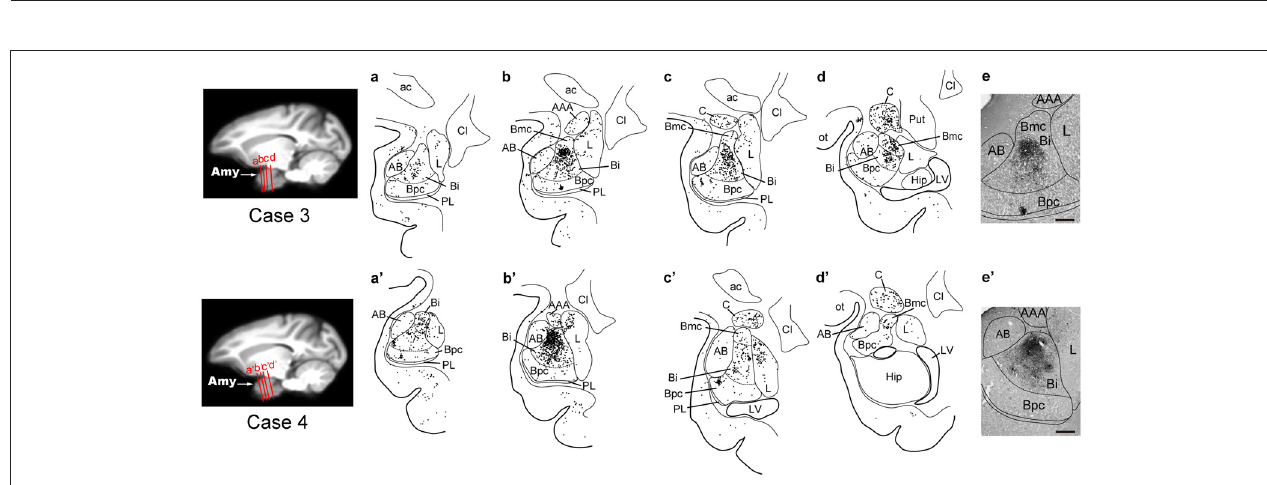
FIGURE 5 | Distribution patterns of the second-order and third-order neuron labeling in the amygdala at the 4-day survival period in Case 3 (upper) and Case 4 (lower). All conventions are as in Figure 4 .